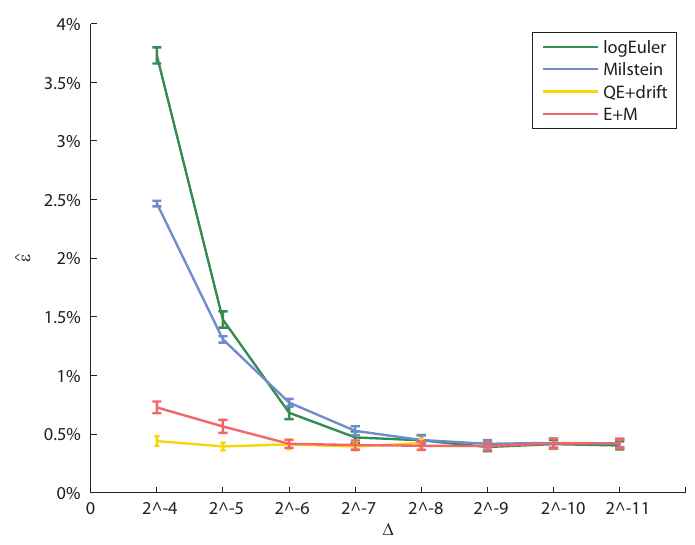
Fig. 10. Results for (cid:129) D 2 (cid:0) 4 (cid:0) 2 (cid:0) 11 , for 100 000 simulated paths, number of batches M D 100 .